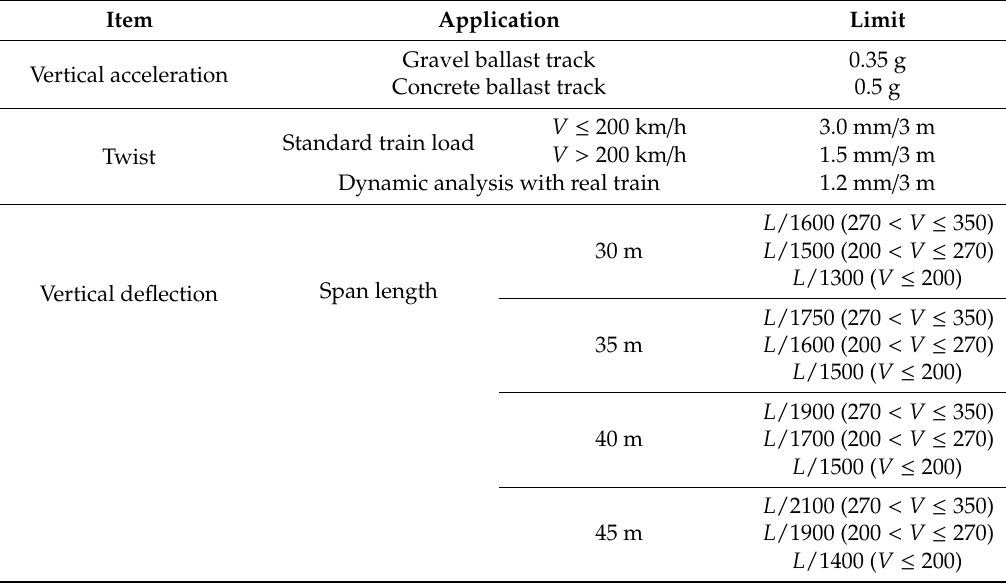
Table 3. Railway bridge specifications for traveling safety and comfort (KSD 24 10 10) [11].